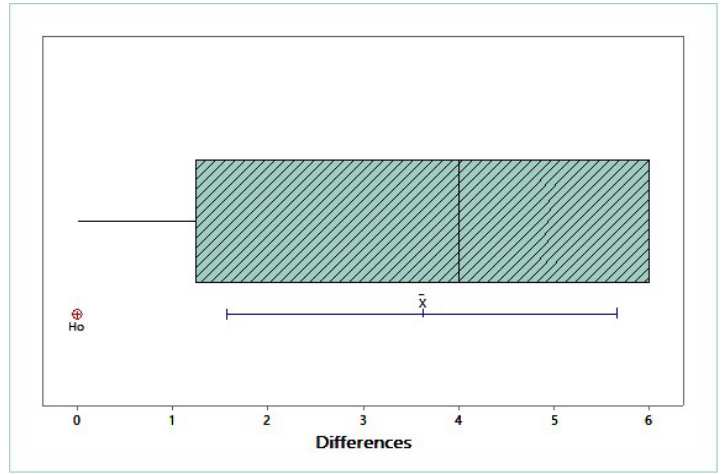
Figure 4. Differences between real and simulated SEPA—Chair pressure (ADL: Prepare